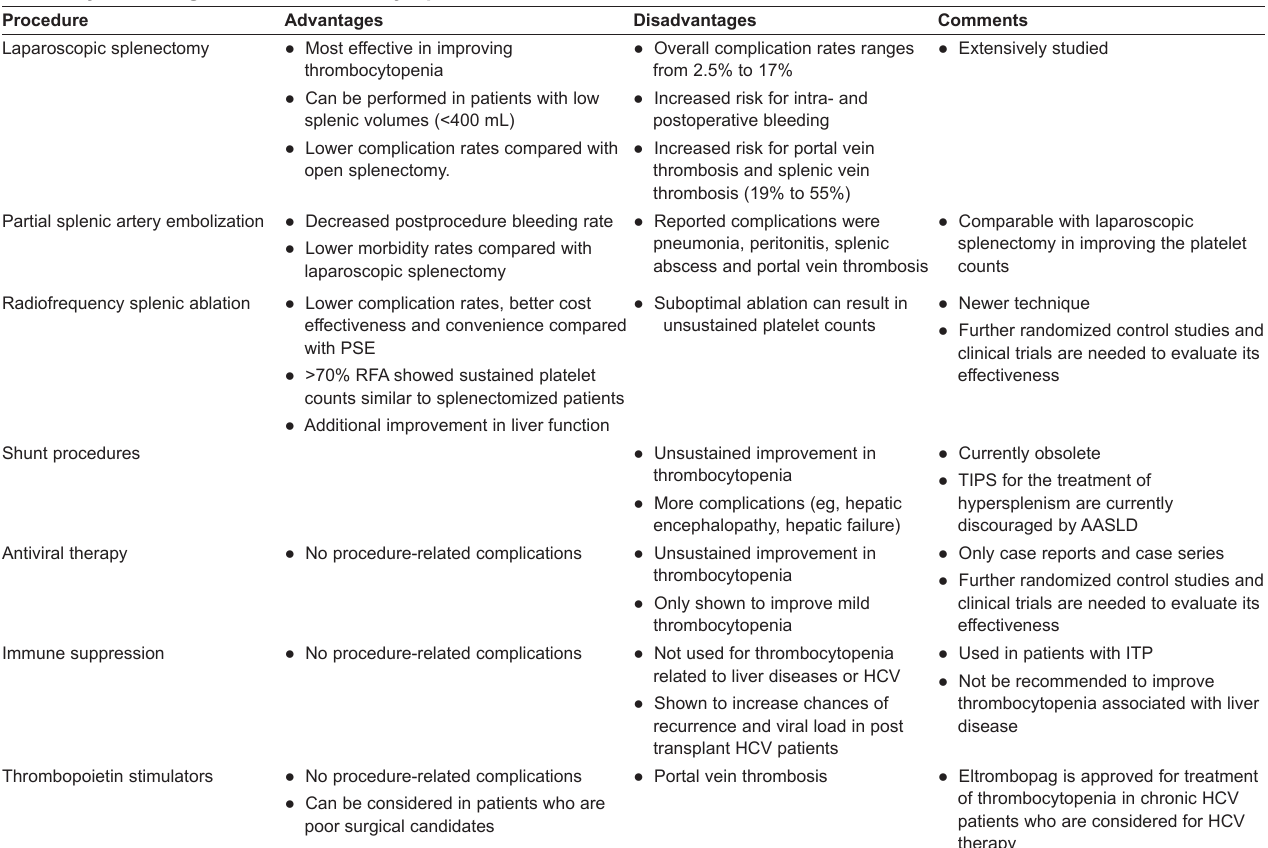
Table 1 Summary of management of thrombocytopenia in liver disease